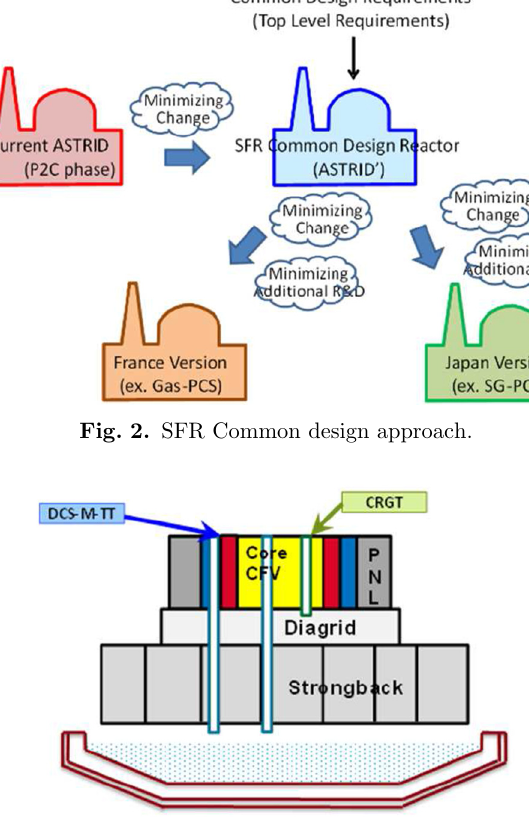
Fig. 3. Schematics of mitigation measures on ASTRID600 (DCS-M-TT: mitigation type safety device to guide the melted core on the core catcher; CRGT: Control Rod Guide Tube; PNL: Lateral Neutronic